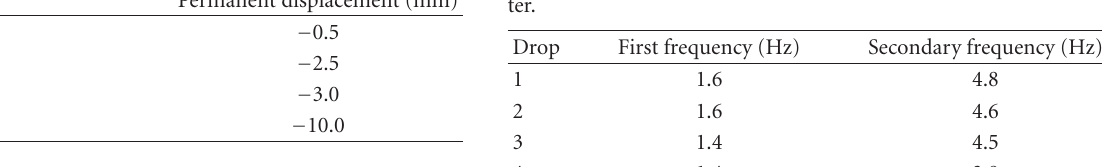
Table 3: LOS permanent displacements of the beam after each drop. Drop number Permanent displacement (mm)